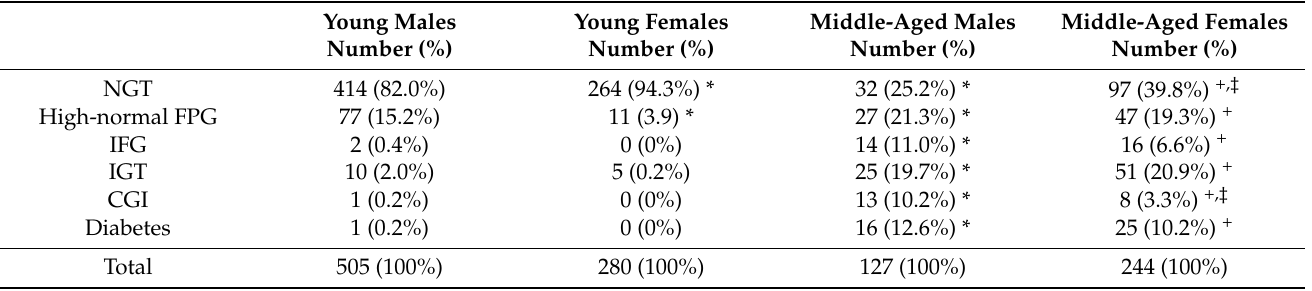
Table 2. Classification of glucose tolerance on 75 g oral glucose tolerance test according to Japanese Clinical Practice Guideline for Diabetes